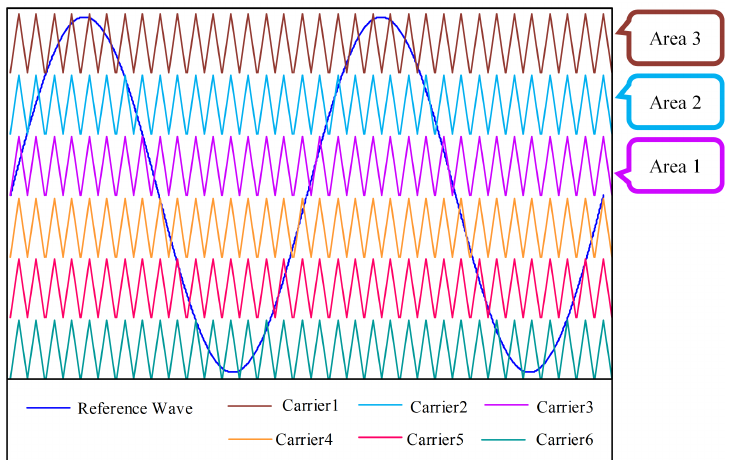
Figure 3. Seven-level LSPWM